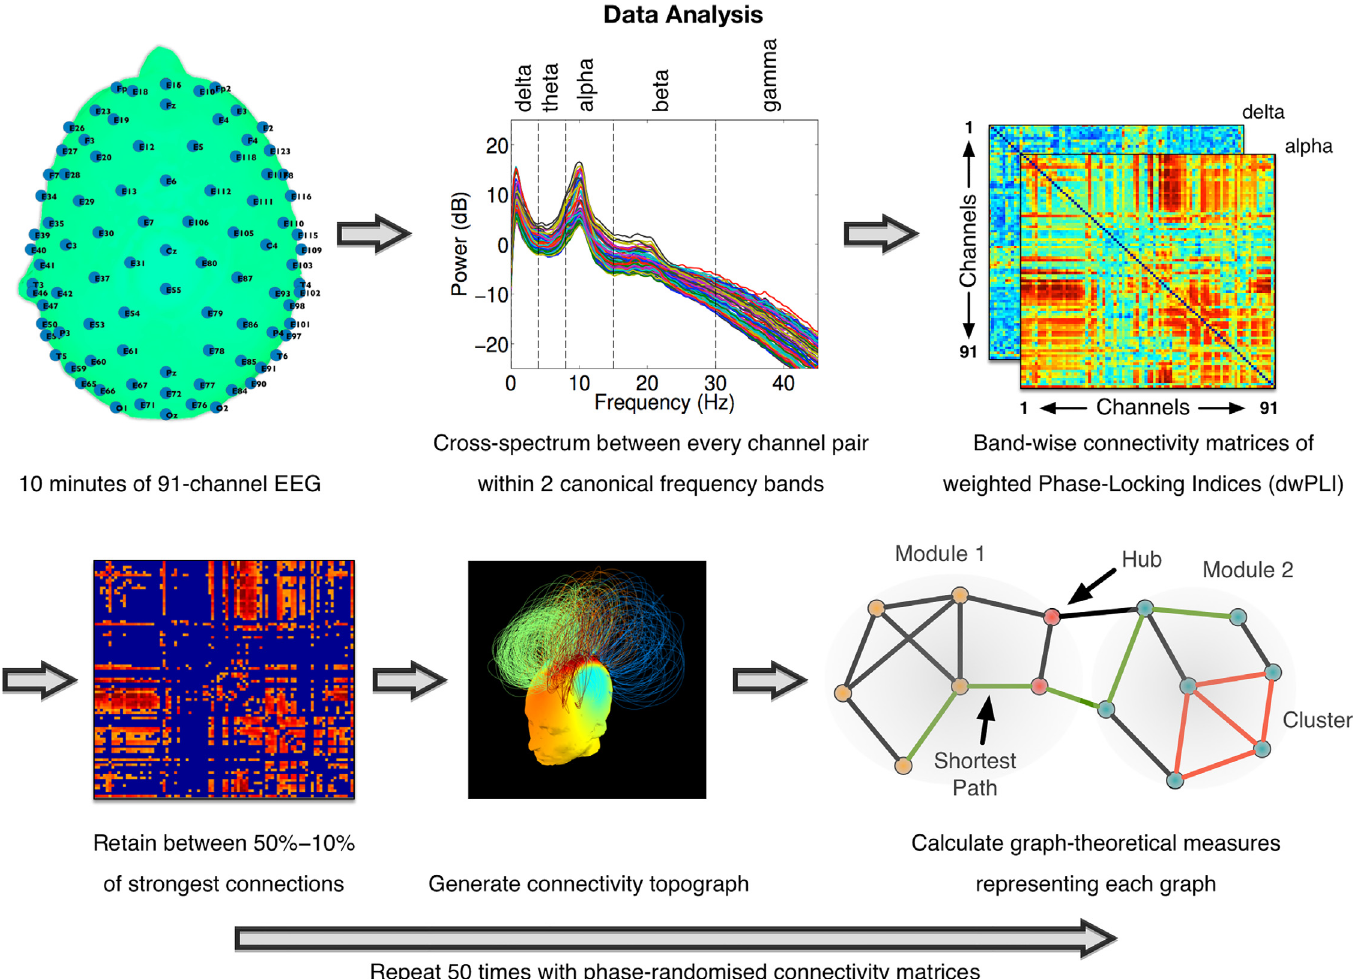
Fig 2. Summary of EEG data analysis pipeline. Cross-spectral density between channel pairs was estimated using dwPLI. Symmetric connectivity matrices generated were thresholded before the estimation of graph-theoretic metrics. In the connectivity matrix shown (bottom left), the threshold has been set to depict only top 30% of strongest connections. In the network topograph (bottom middle), intra-modular links in modules identified by the Louvain algorithm are indicated by